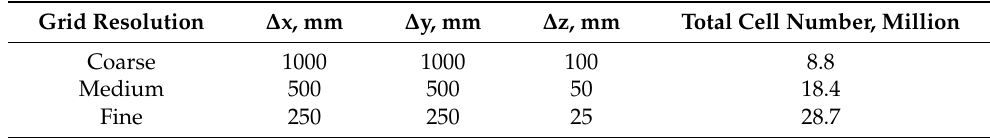
Table 1. Mesh convergence study.